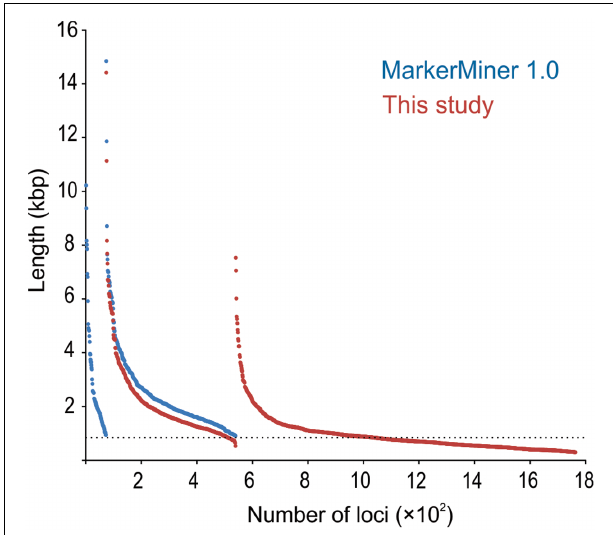
FIGURE 3 | Length distribution of SCG loci of Lindenbergia philippensis identified by MarkerMiner (blue) and by BaitsFinder (red). Loci are organized in three panels (found by MarkerMiner only; found by both MarkerMiner and BaitsFinder; found by BaitsFinder only) and, within each panel, are sorted by length.